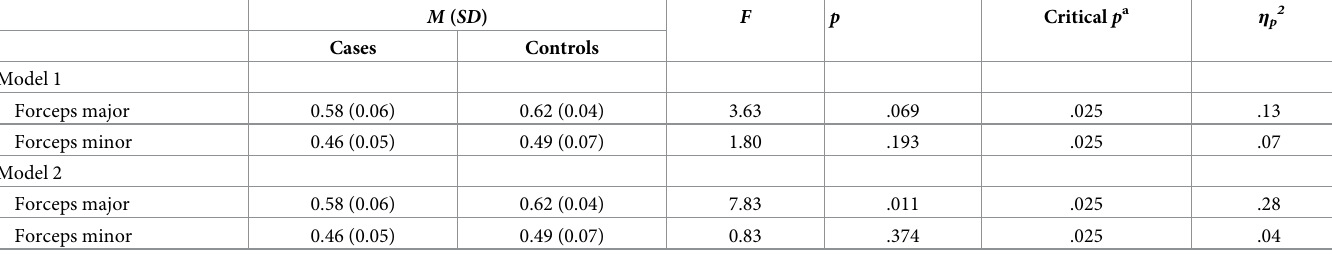
Table 2. Fractional anisotropy in the corpus callosum among cases (n = 13) and controls (n = 13).